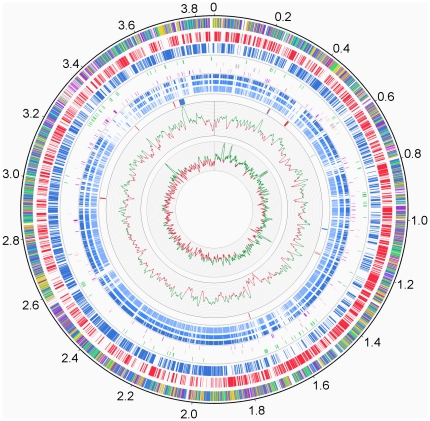

Arthrobacter arilaitensis Re117 genome atlas.The outermost circle (circle 1) represents the scale in Mbp. Circle 2 represents the functional category of the CDSs: green, cell envelope and related processes; blue, intermediary metabolism; yellow, information pathways; orange, other functions; dark purple, proteins of unknown function that are similar to other proteins; light purple, proteins of unknown function without similarity to other proteins. Circles 3 and 4 represent CDSs (excluding transposases) on positive (red) and negative (blue) strands. Circle 5 represents the insertion sequences (in green). Circle 6 represents rRNA (grey) and tRNA (red) genes. Circle 7 represents the pseudogenes (excluding transposase pseudogenes). Circles 8, 9 and 10 represent CDSs (in blue) orthologs (predicted as defined in section “Genome analysis and annotation”) with genes from three environmental Arthrobacter strains: A. chlorophenolicus A6 (circle 8), Arthrobacter sp. FB24 (circle 9) and A. aurescens TC1 (circle 10). Circle 11 represents genes involved in siderophore biosynthesis and export (blue) and in Fe3+/siderophore complexes import (red). Circle 12 and 13 represent the G+C content and GC skew (G−C)/(G+C), respectively, each plotted using a 10-kb window.